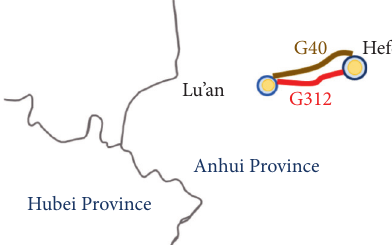
Figure 3: Diagram of the highway connection between Hefei and